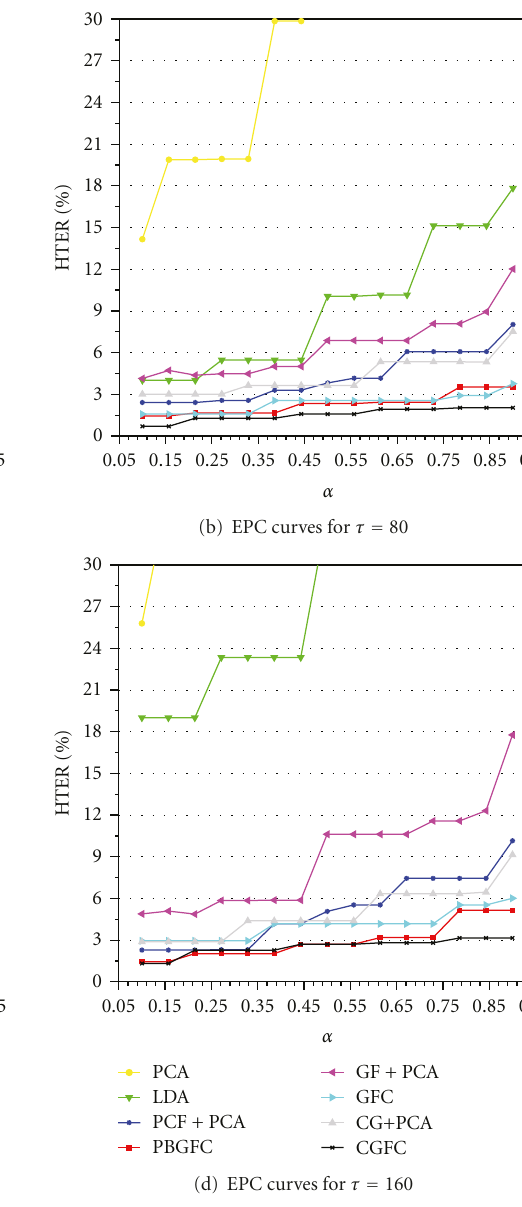
Figure 22: EPC curves obtained on the test sets of the XM2VTS database for di ff erent values of the parameter τ .